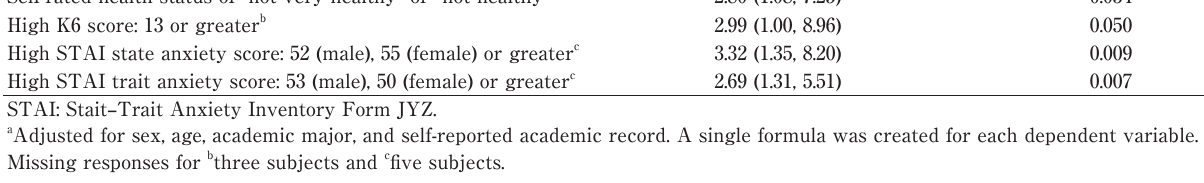
Table 4. Associations between high Modified Stressor Scale for College Student (M-SSCS) total scores (top quartile) and health characteristics (n = 198) Dependent